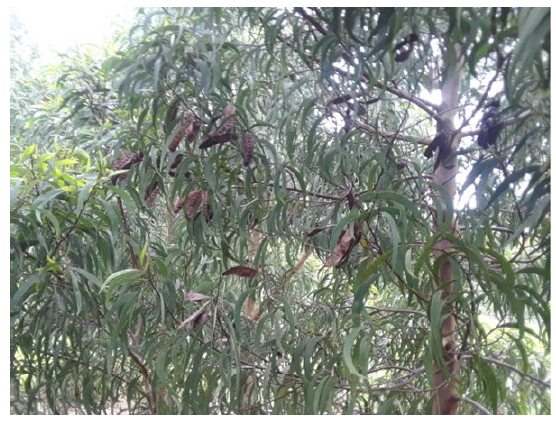
Figure A4. Mature koa seed pods ready to harvest at 30 months.